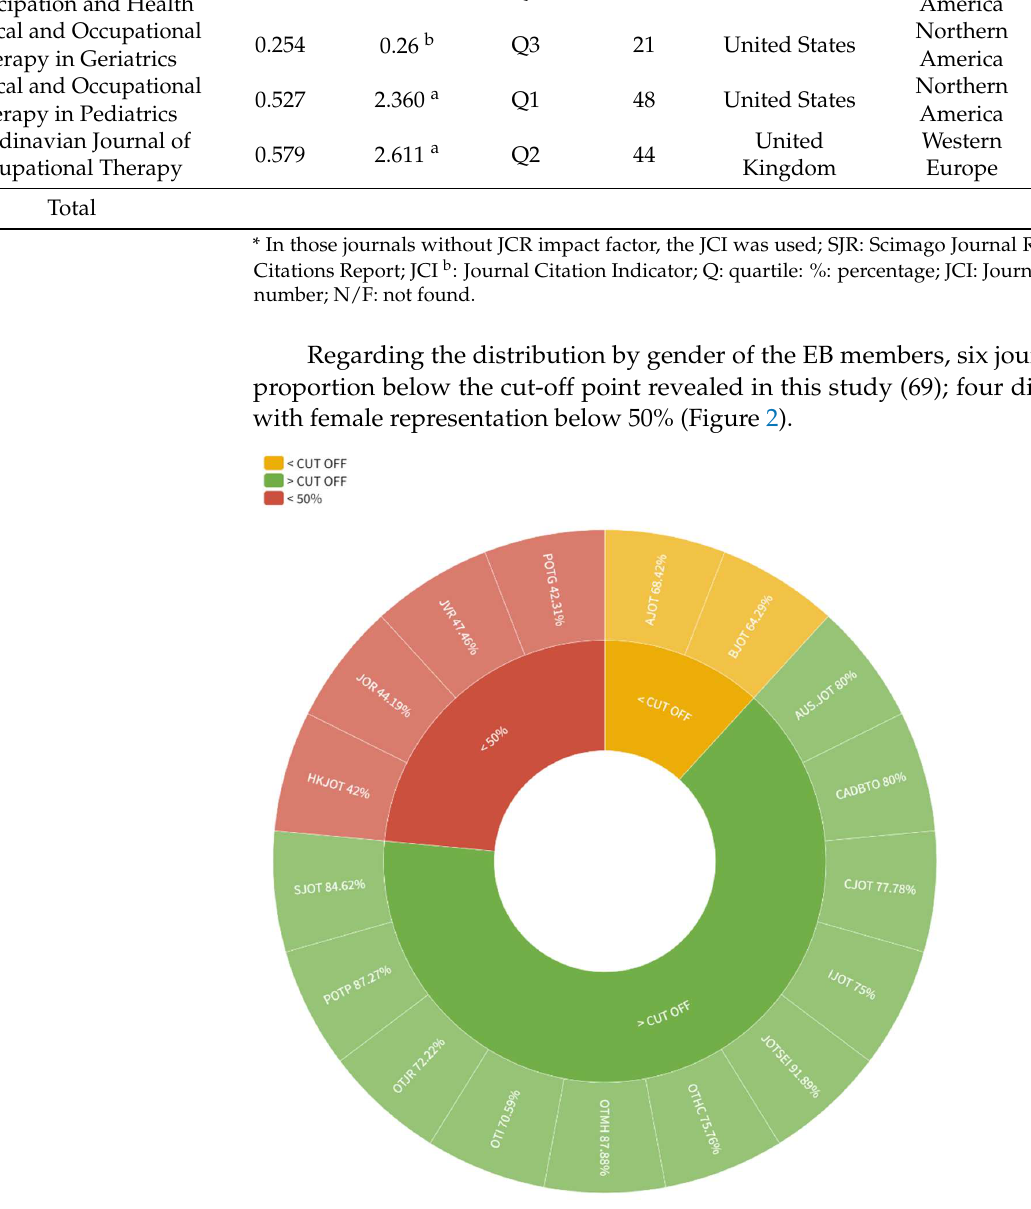
Figure 2. Distribution by gender of the editorial board members. JOTSEI: Journal of Occupational Therapy, Schools, and Early Intervention; OTMH: Occupational Therapy in Mental Health;